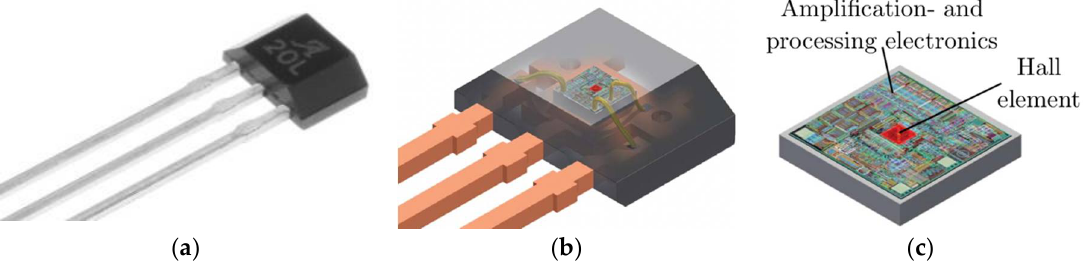
Figure 6. Hall effect sensor. ( a ) Electrical sensor component, reproduced from [26]. Copyright 2009-2013, Allegro MicroSystems, LLC; ( b ) Inner view of a Hall effect sensor comprising the mounted die and the bond wire connections to the external pins for supply, output signal and GND (from left to right) [27]; ( c ) Hall Integrated Circuit (IC) chip, reproduced from [27]. Copyright 2009–2013, Allegro MicroSystems, LLC.